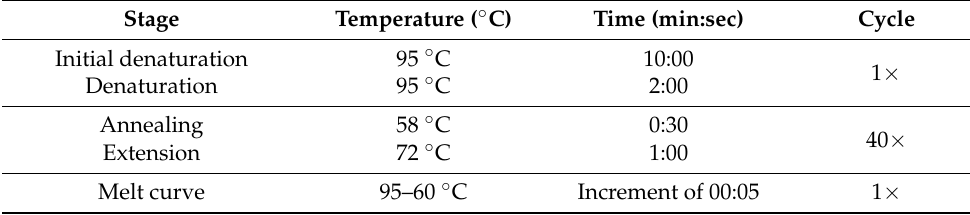
Table 1. PCR program used in this study.